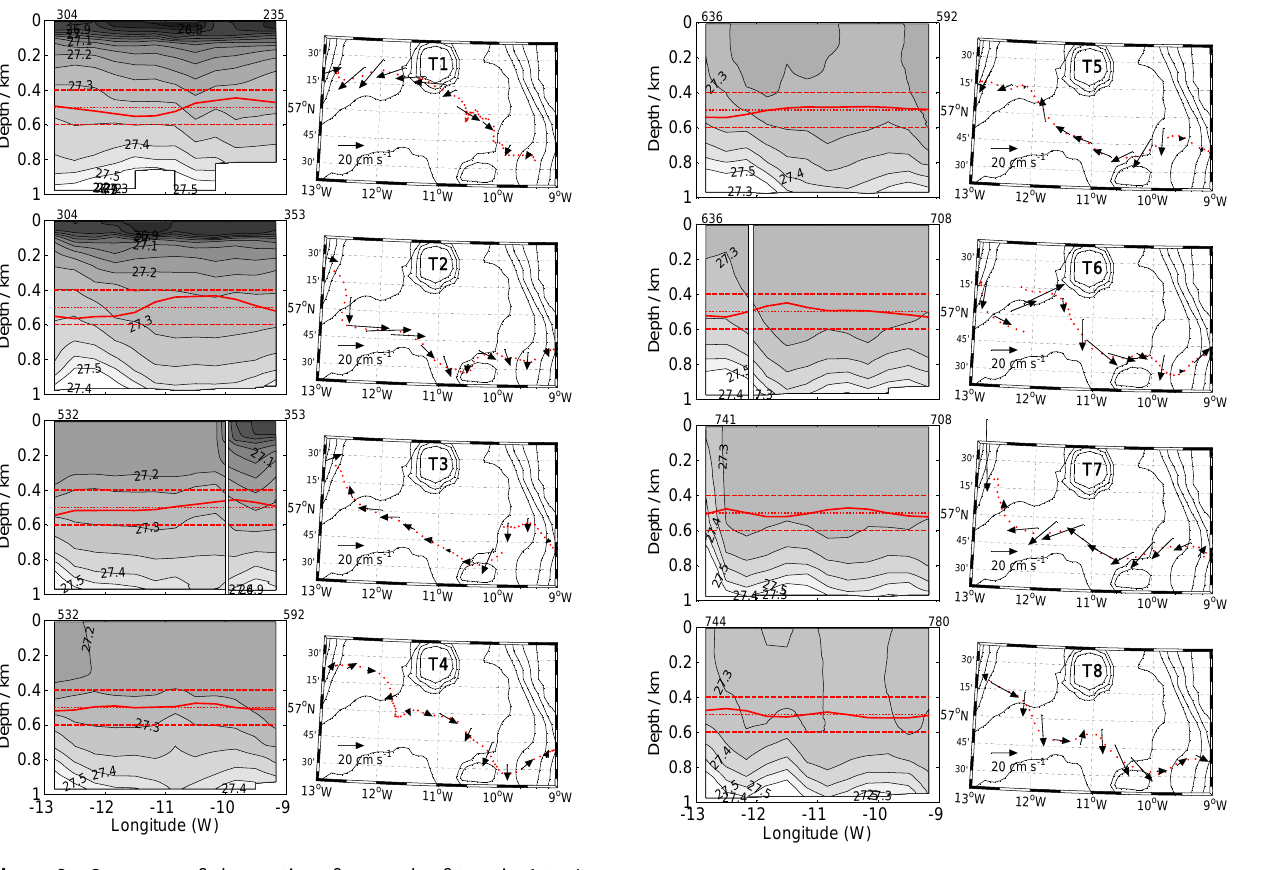
Figure 6b. Same as Fig. 6a but for tracks 5–8